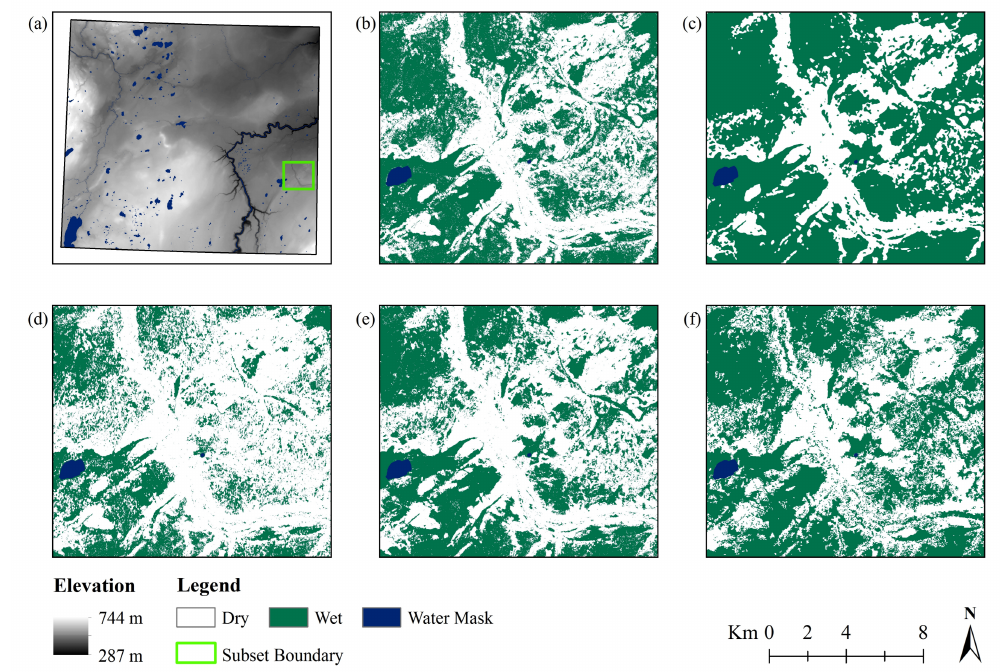
Figure 8. Local variations in wetland classification for the area located within a southeastern subsection of the study area delineated by the green box in ( a ), for ( b ) T model , ( c ) TO model , ( d ) TS model , and ( e ) TOS model models, as well as ( f ) the AMWI.